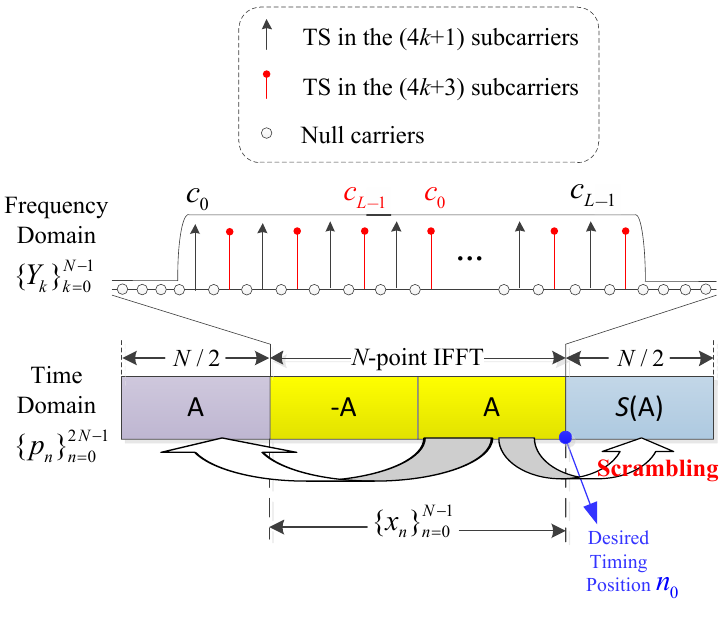
Figure 2. Proposed OFDM preamble